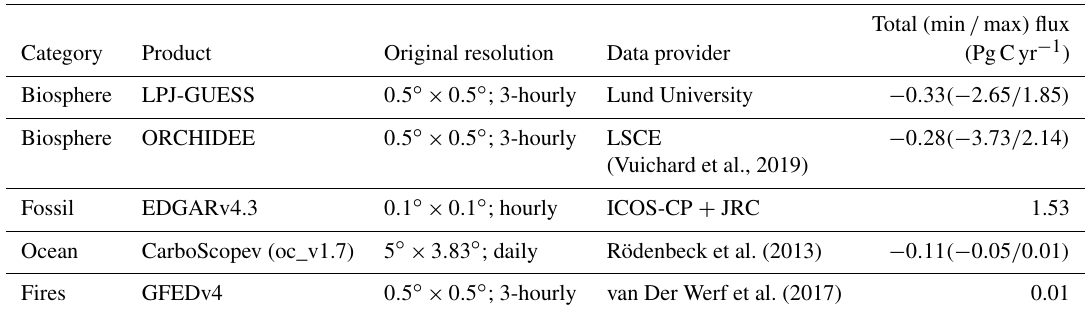
Table 2. Prior and prescribed CO 2 fluxes. Min / max values are provided for the fluxes that have both positive and negative components and correspond to the minimum and maximum values of the 3-hourly flux aggregated over the entire domain (PgCyr − 1